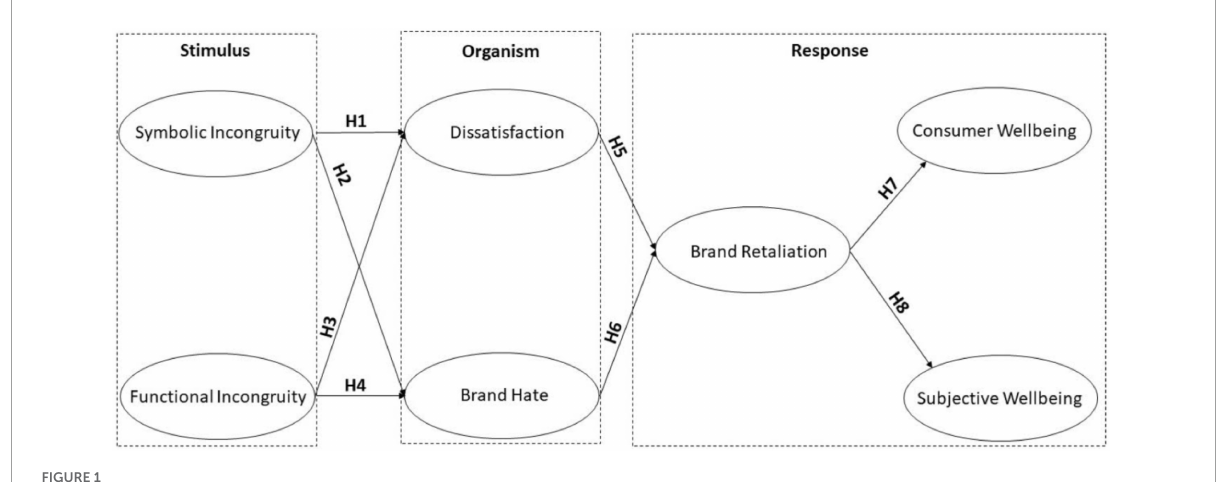
FIGURE1 Conceptual